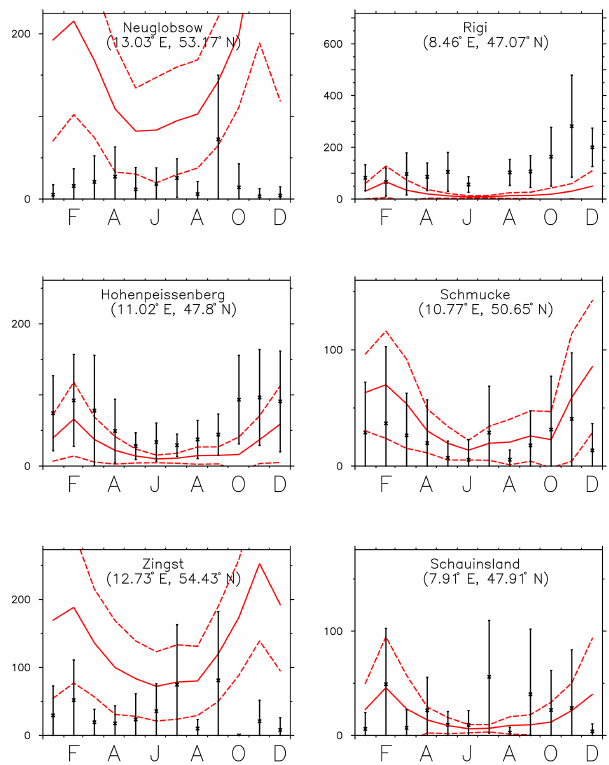
Figure 6. Mixing ratios of xylenes (pmolmol − 1 ) from EMEP ob- servations in the year 2005 (monthly average) (in black), and from the LIT simulation (in red). Error bars show the standard deviation of the observations, red dashes show the standard deviation of the model